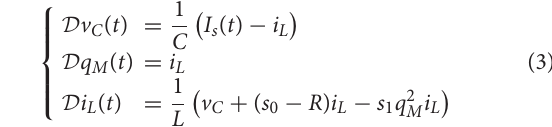
of convergent and oscillatory behaviors, which are generated